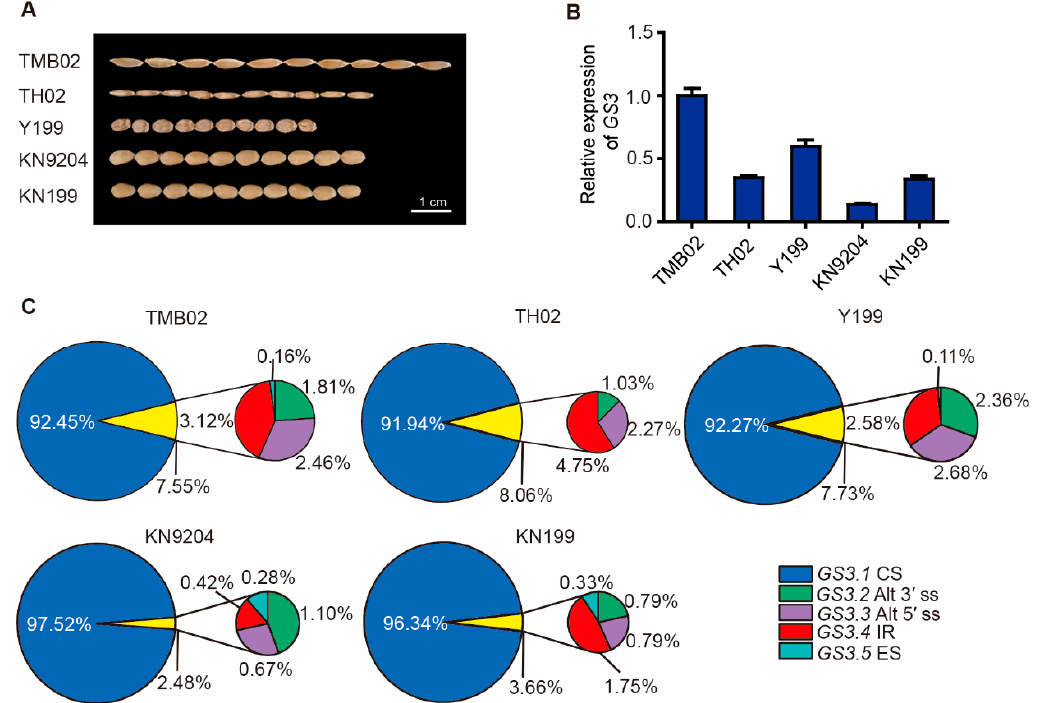
Figure 2. The occurrence frequency of GS3 splicing variants in diploid wheat progenitors and hexaploid wheat. ( A ) Phenotypic comparison of grain traits among the indicated diploid wheat progenitors and hexaploid wheat cultivars. Bar = 1 cm. ( B ) Relative expression of GS3 in mature seeds of the indicated diploid wheat progenitors and hexaploid wheat cultivars. Normalized expression values of GS3 splicing variants relative to GAPDH were given as mean ± SEM from three replicates. ( C ) The occurrence frequency of GS3 splicing variants in developing grains of the indicated diploid wheat progenitors and hexaploid wheat cultivars. The GS3 splicing variants and AS types are represented by different colors (dark blue, green, purple, red, and light blue stand for GS3.1 CS, GS3.2 Alt 3 ′ ss, GS3.3 Alt 5 ′ ss, GS3.4 IR, and GS3.5 ES, respectively).